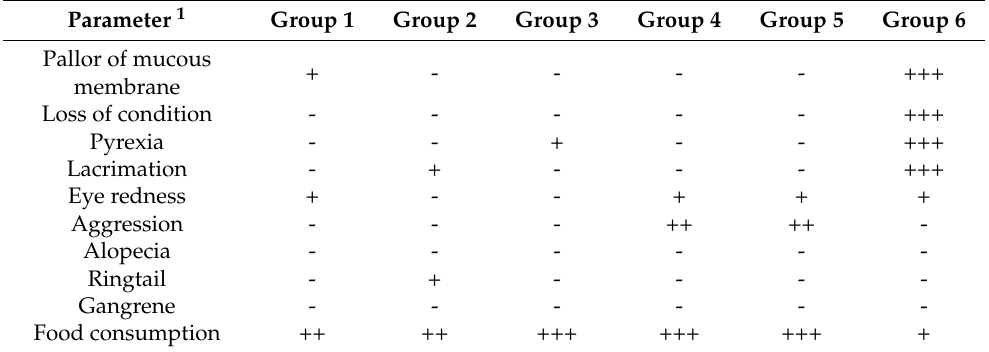
Table 3. Physical and behavioral changes of experimental animals.